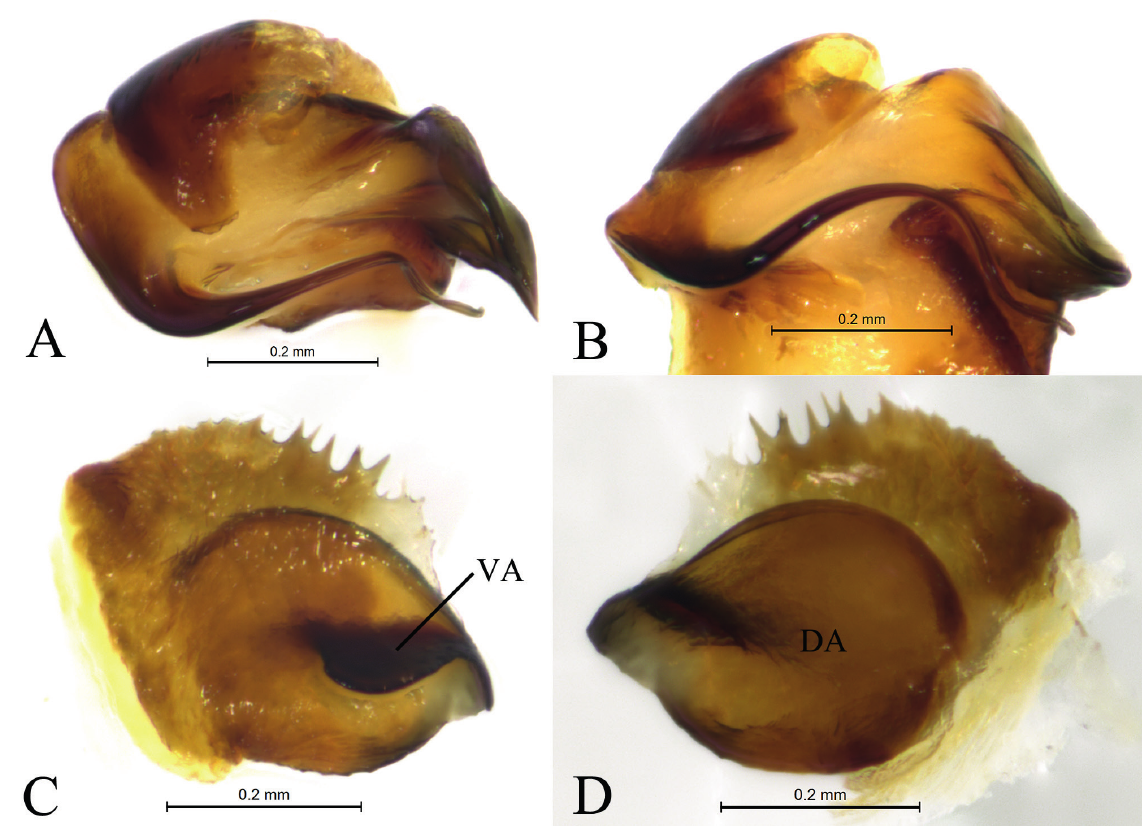
Fig. 1. Serratacosa medogensis gen. et sp. nov. A . Embolus and terminal apophysis, ventral view. B . Embolus and terminal apophysis, bottom view. C . Median apophysis, ventral view. D . Median apophysis, dorsal